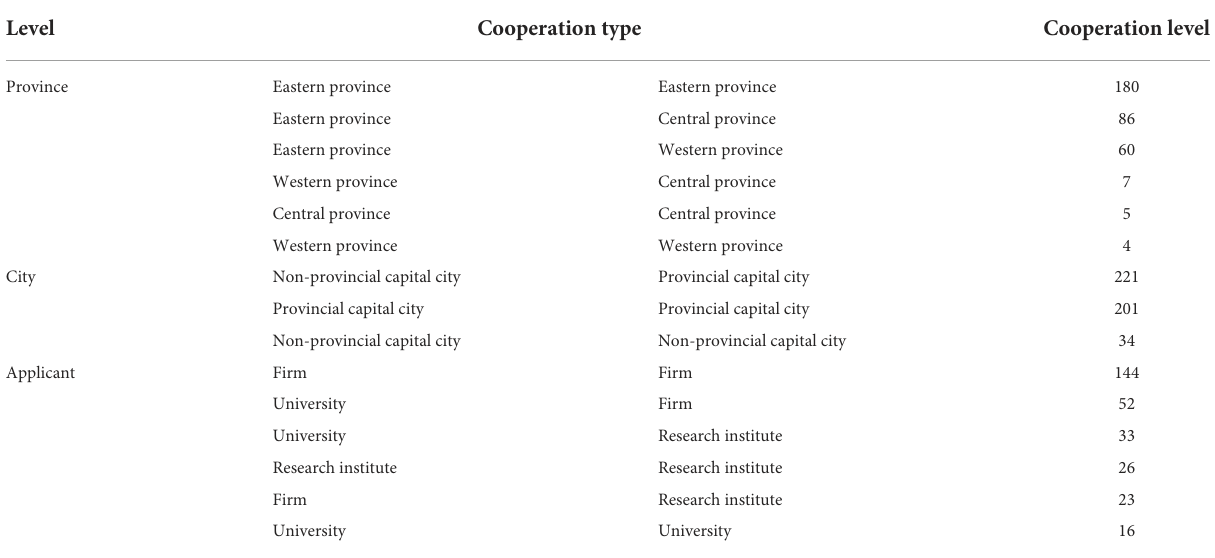
TABLE 1 Types and levels of COVID-19 patent cooperation.